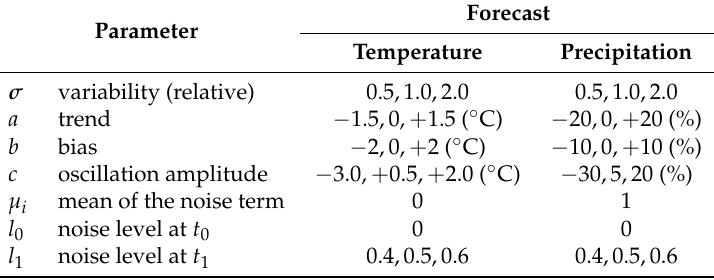
Table 1. Parameters used to create the synthetic temperature and precipitation forecasts (see Equations (1) and (2) for details). Note that the values for σ are given relative to the ones used to produce the synthetic reference time series (a value of, e.g., “2” means that σ day , σ mon , σ yr were doubled).